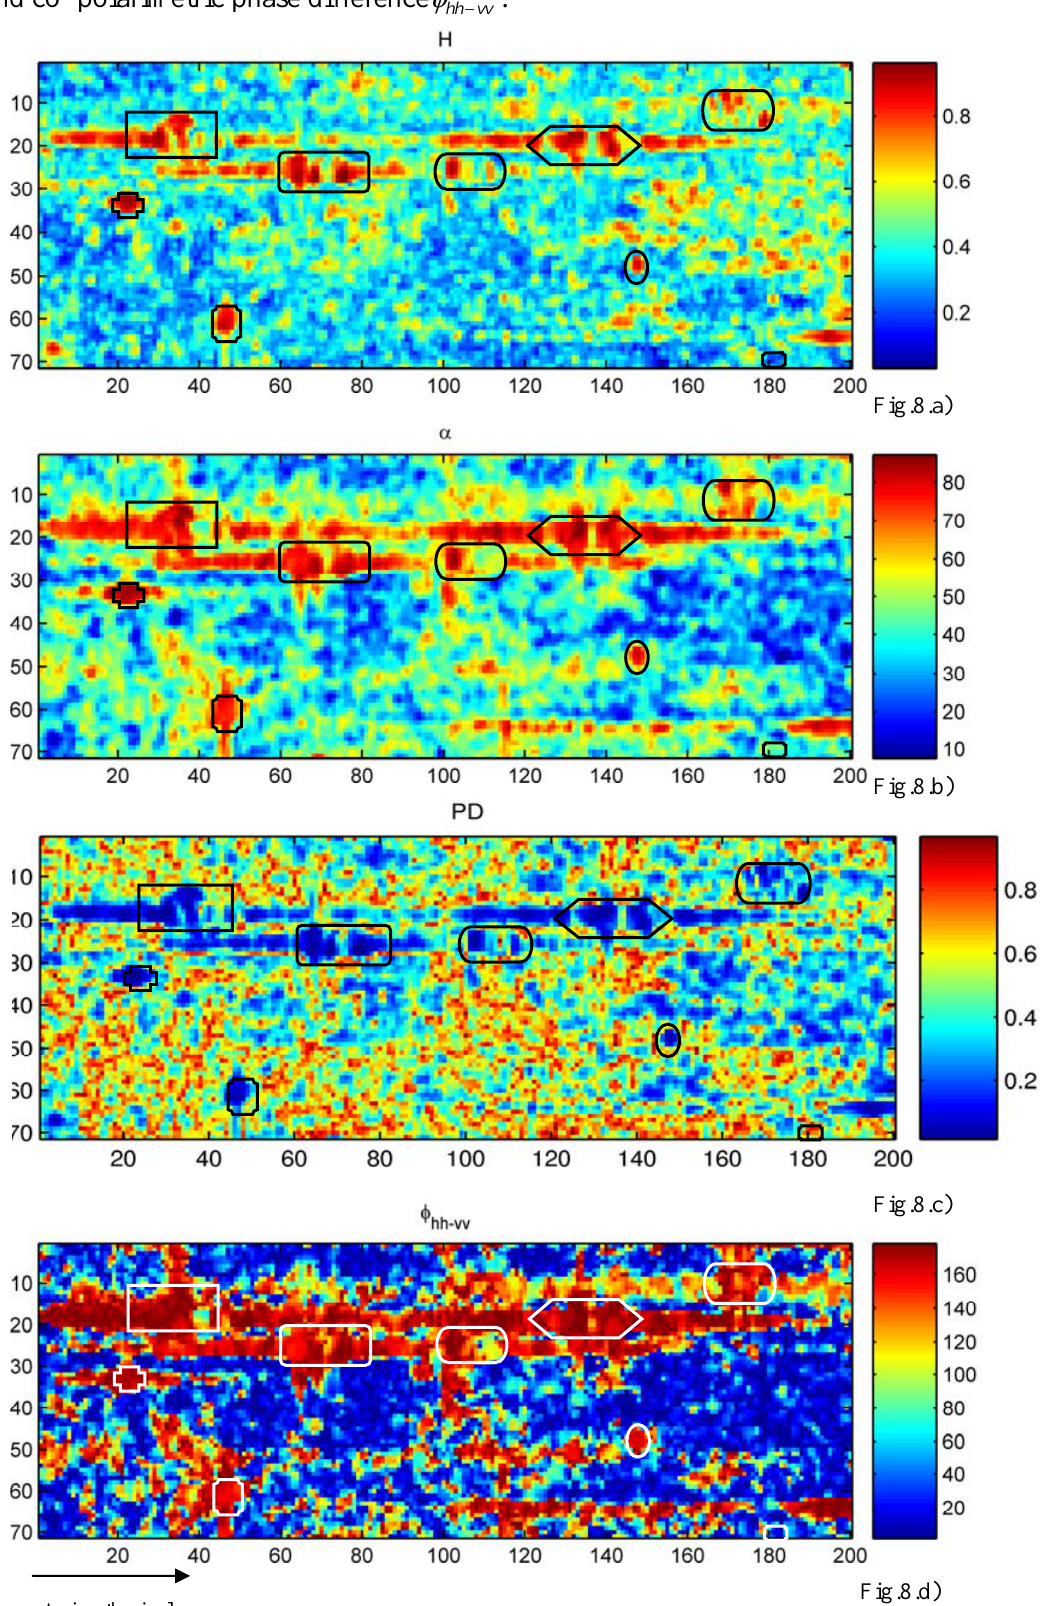
Figure 8. Validating the results of convolution with polarimetric parameters. a, b, c and d show the images of polarimetric entropy H , scattering angle  , polarimetric degree PD and co- polarimetric phase difference  vvhh 